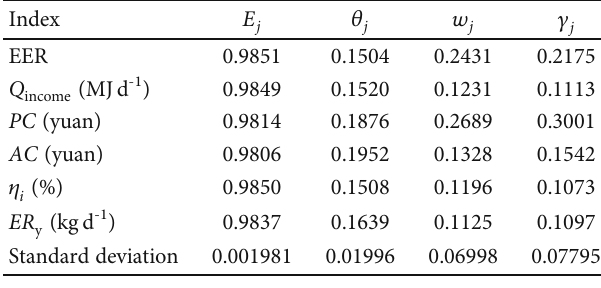
Table 10: Entropy and weight of each index.